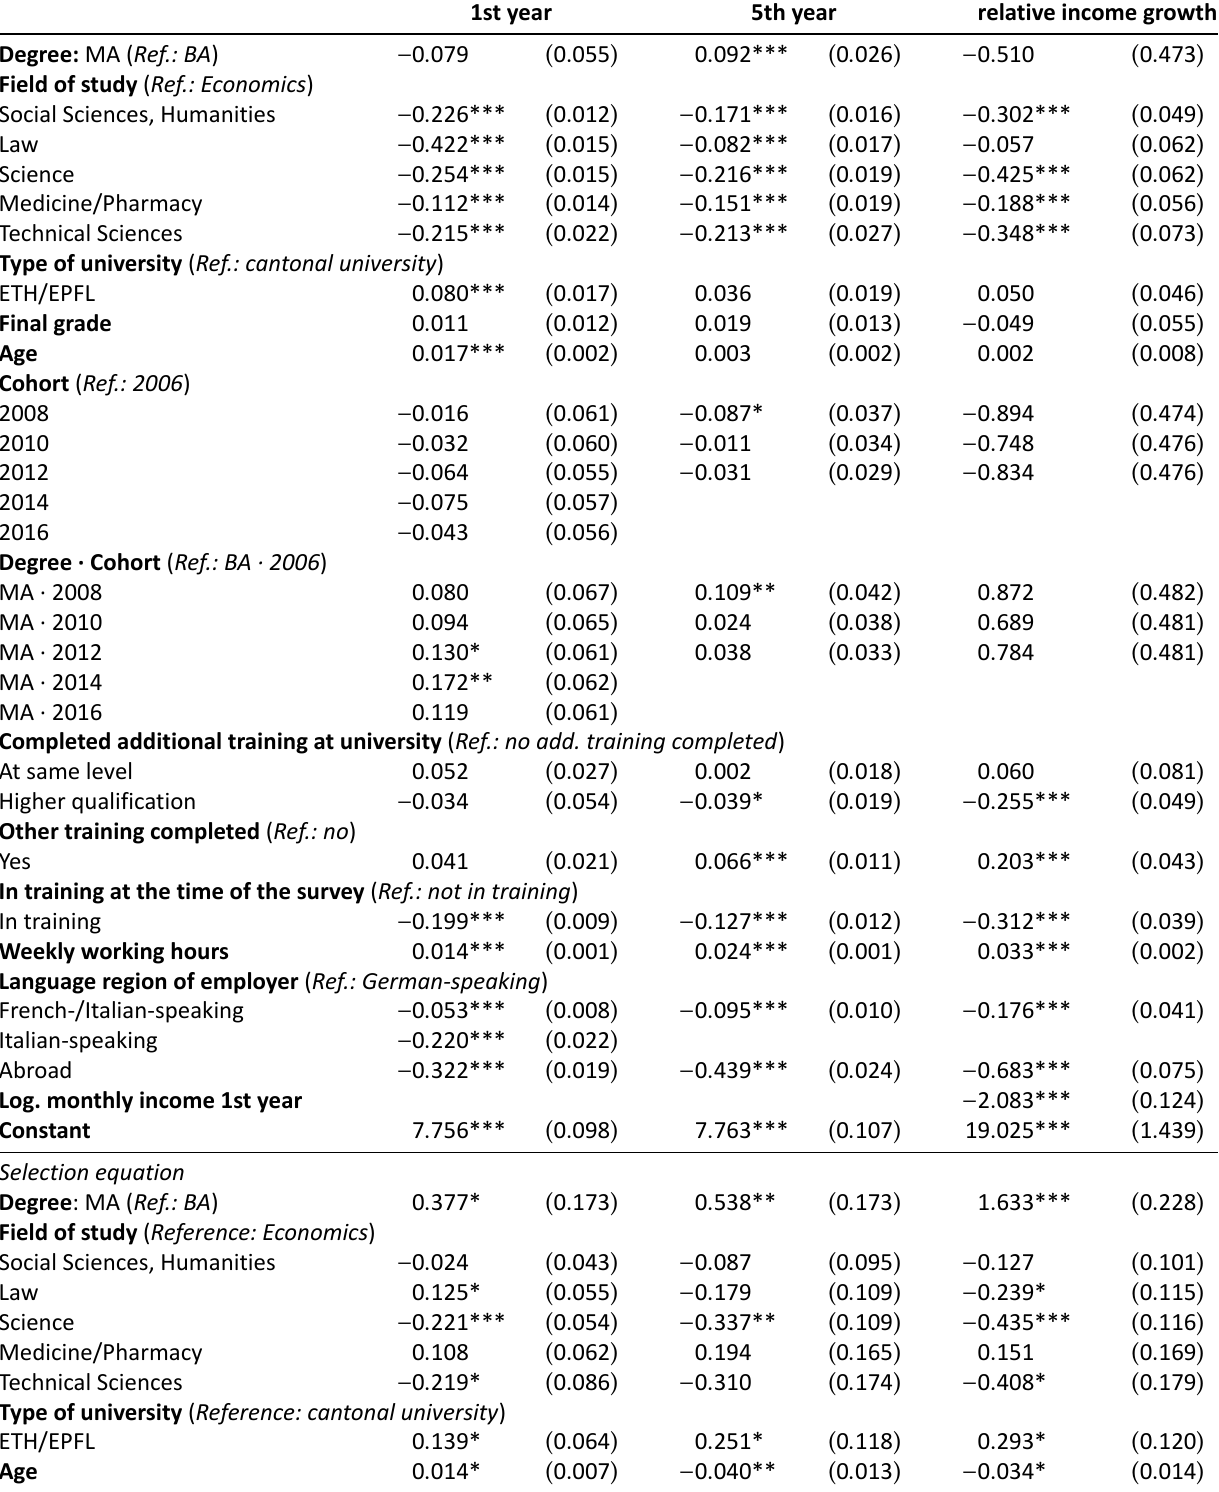
Table A6. Women’s monthly income (log.) in the first and fifth year after graduation and their relative income growth; models with interaction terms—shown in Figure